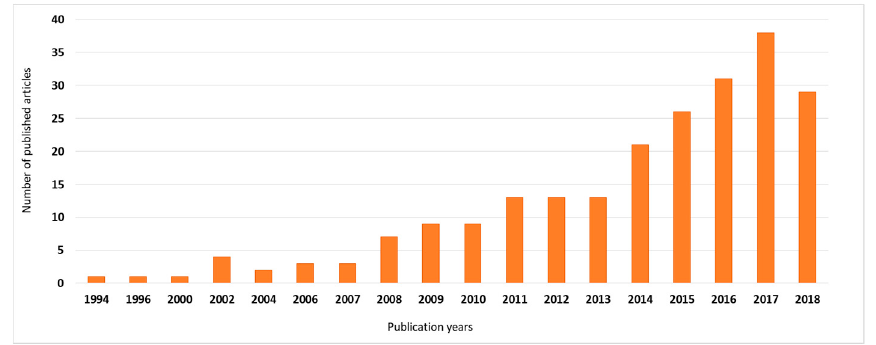
Figure 4. Classification of articles by year of publication based on search in Web of Science.